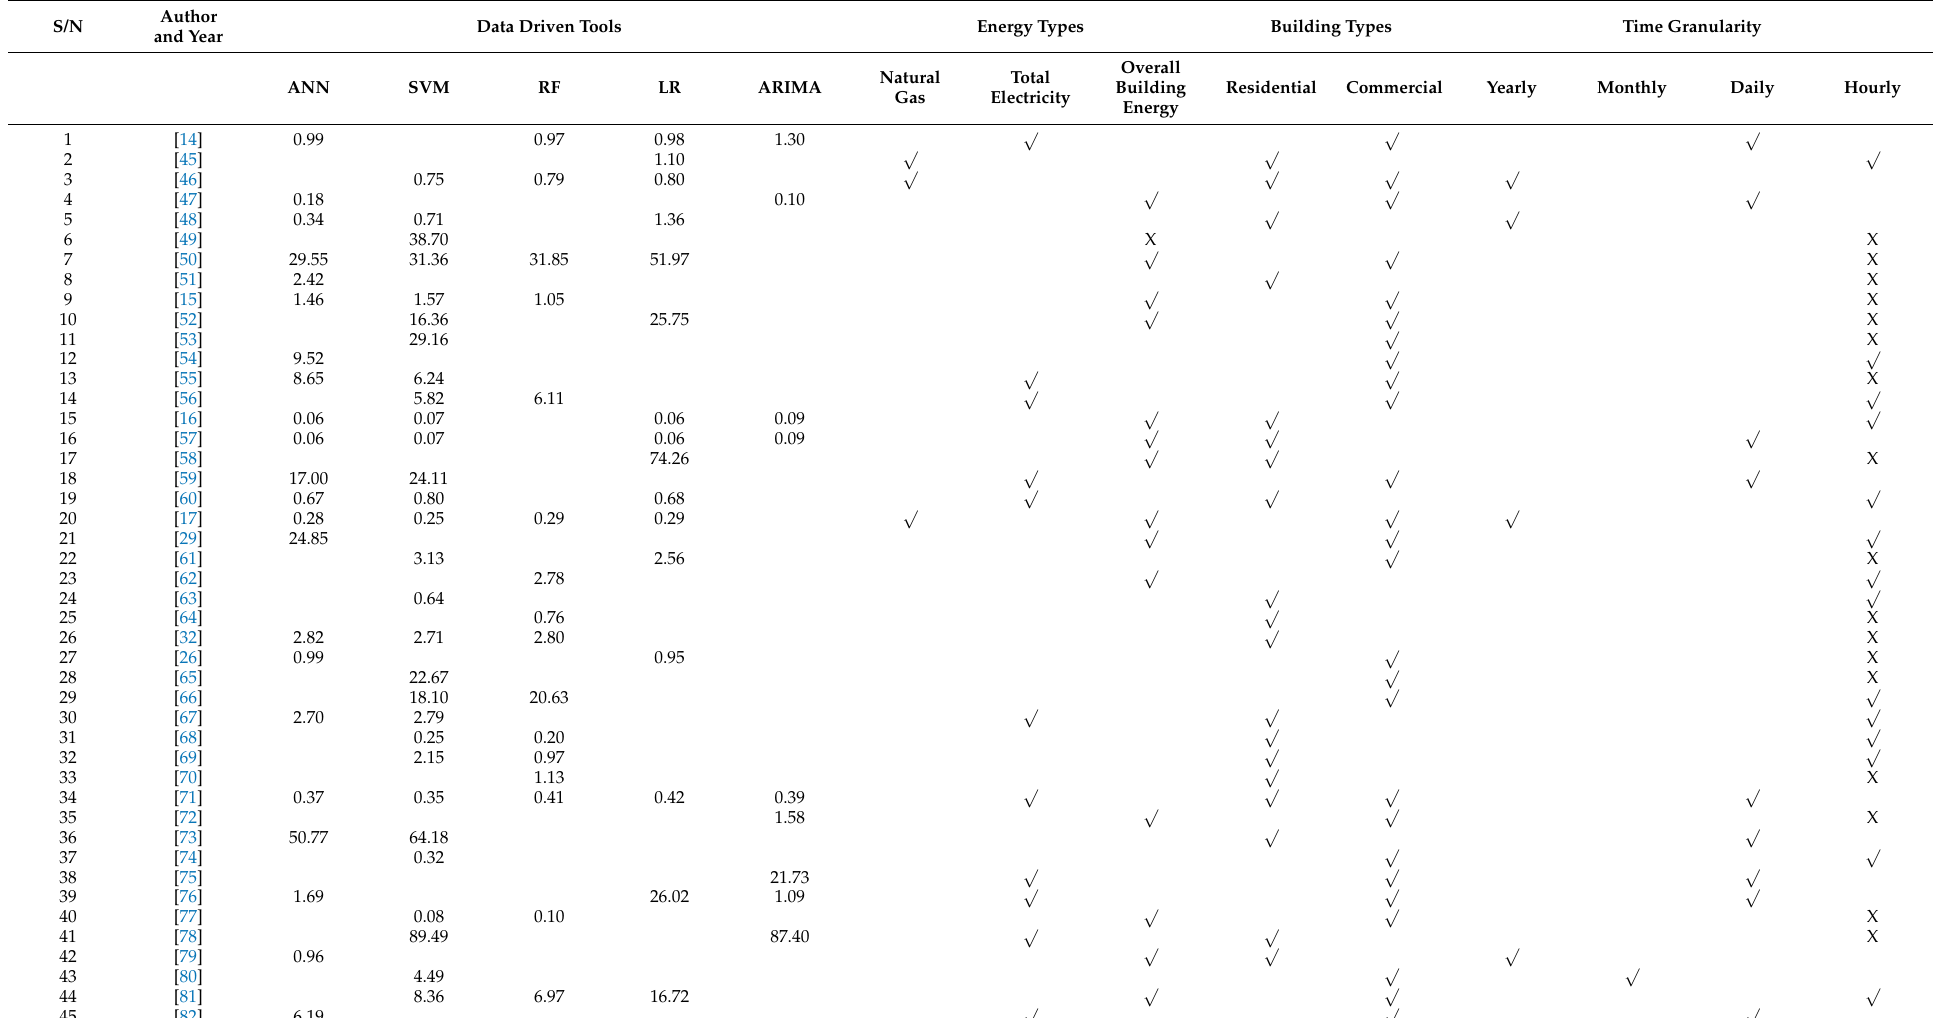
Table 2. Performance of data-driven tools employed in reviewed